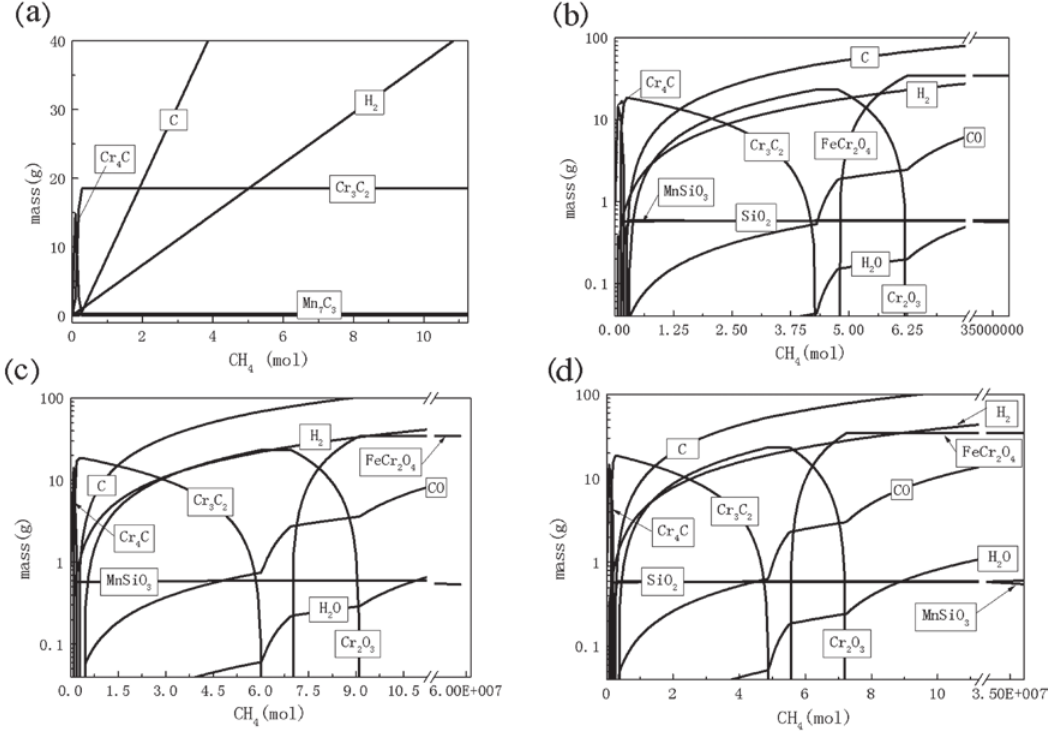
Fig. 7: Equilibrium of (a) pure CH 4 , (b) CH 4 with O 2 (m(O 2 ):m(CH 4 ) = 0.12:1), (c) CH 4 with CO 2 (m(CO 2 ):m(CH 4 ) = 0.12:1), (d) CH 4 with H 2 O (m(H 2 O):m(CH 4 ) = 0.12:1) to Fe-Cr alloys at 800 °C.